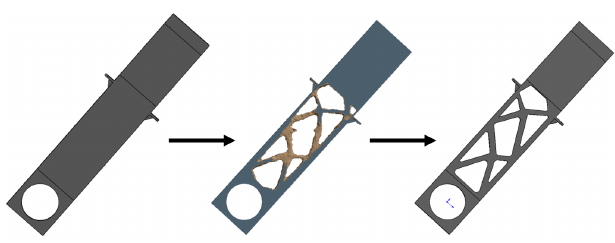
Table 7. Comparison of relevant parameters of upper and lower rope wheels before and after im- provement. Upper and Lower Rope Wheels